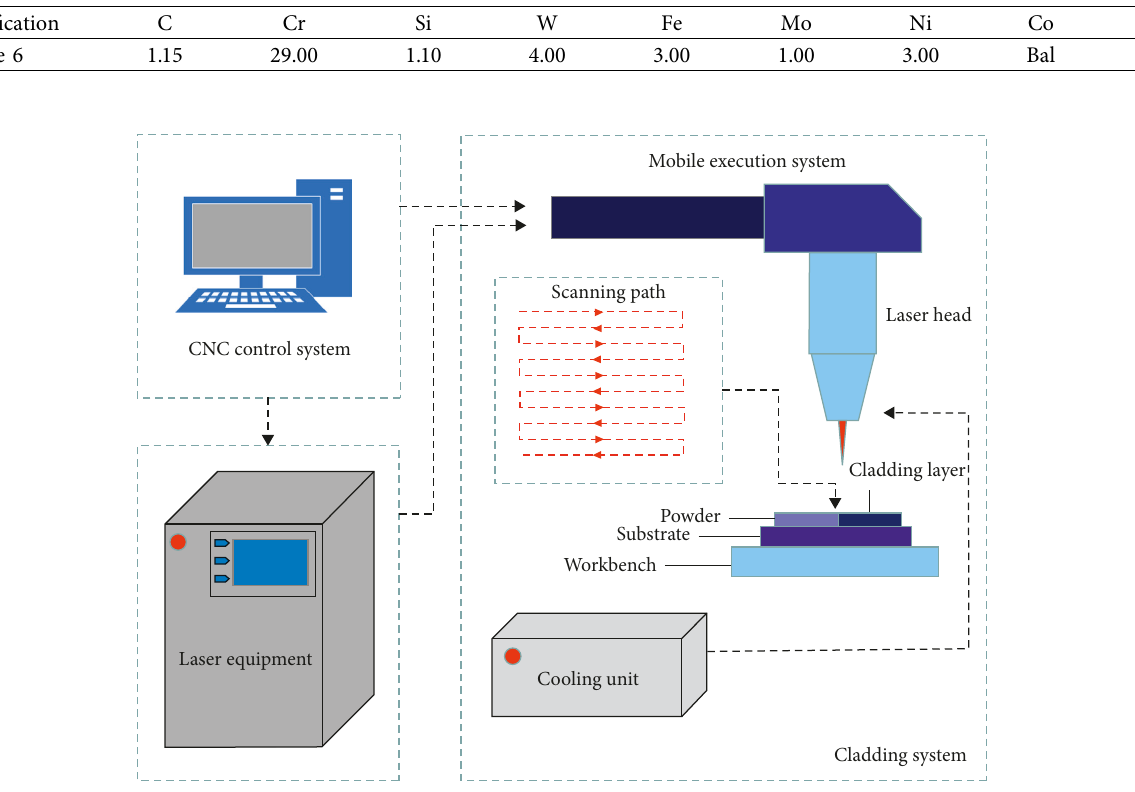
Figure 1: The laser cladding